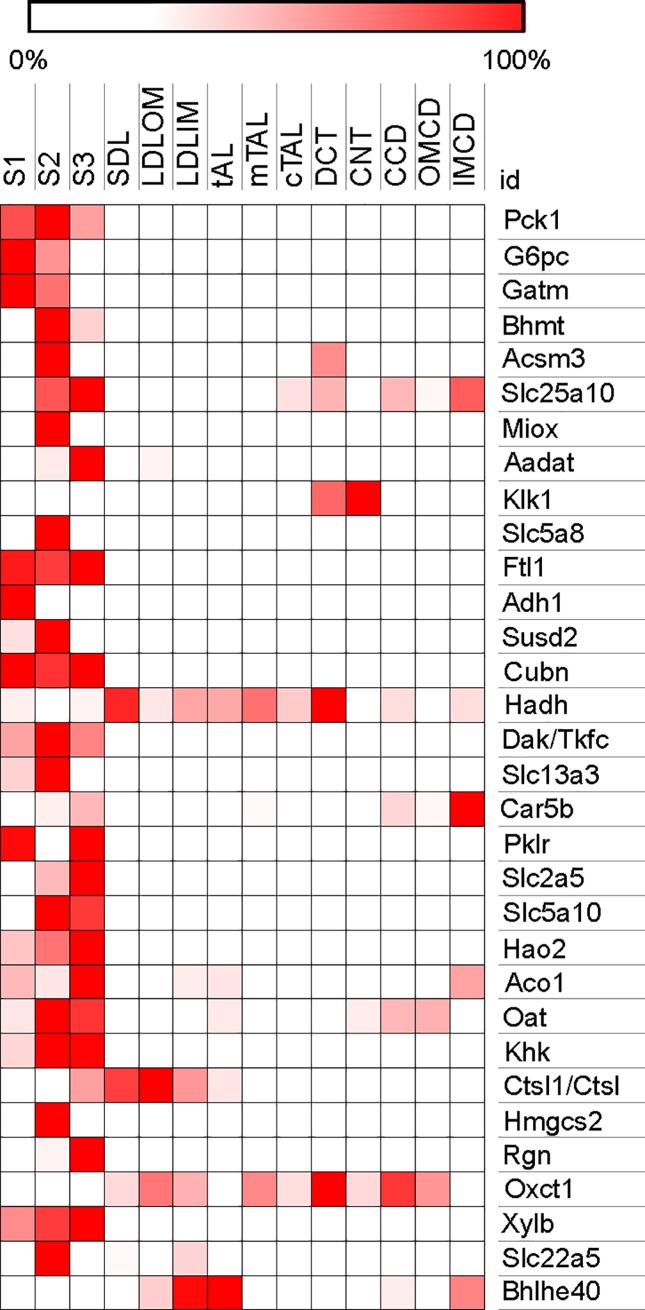
Distribution of expression of 32 of the top annotated fructose signature genes along the nephron.Expression data are from the database at https://hpcwebapps.cit.nih.gov/ESBL/Database/NephronRNAseq/All_transcripts.html [8]. Nephron segments: S1, S2, S3 = segment 1, 2, and 3 of proximal tubule, respectively; SDL = short descending limb of the loop of Henle; LDLOM and LDLIM = long descending limb of the loop of Henle in the outer and inner medulla, respectively; mTAL and cTAL = medullary and cortical segments of thick ascending limb, respectively; DCT = distal convoluted tubule; CNT = connecting tubule; CCD = cortical collecting duct; OMCD and IMCD = outer and inner medullary collecting duct, respectively. Attempts were made to map the top 34 genes of the fructose signature; whose DE represent 80% of the fructose signature DE. However, 2 genes are not present in the data base or have zero expression. The heat map was generated with Morpheus software https://software.broadinstitute.org/morpheus.